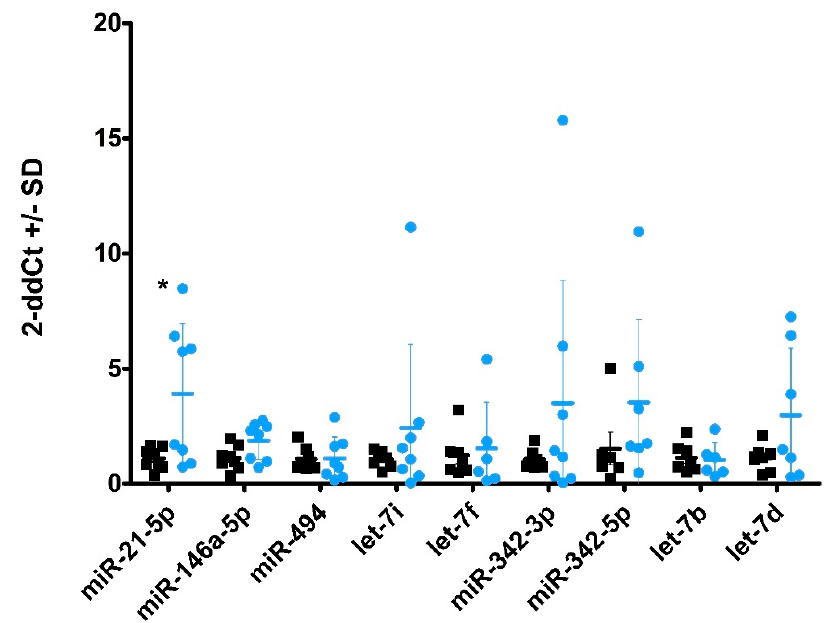
Figure 3. miRNA profiles in plasma-derived sEVs. Fold-change of miRNAs in sEVs derived from blood plasma of scrapie sheep (blue circles) compared with control sheep (black squares) as measured by qPCR. Nine miRNAs were found at detectable levels. Significantly increased levels were found for miR-21-5p ( p < 0.05). Data are expressed as a relative expression value after 2 − ∆∆ Ct conversion using the mean of healthy control sheep as a calibrator, +/ − standard deviation (SD). Statistical significance was assessed by Student’s t -test (* p < 0.05). The Exiqon kit was used for sEVs